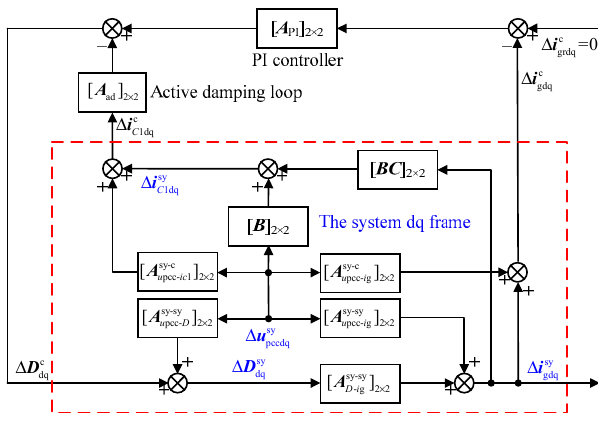
Figure 2. The diagram of PLL description.